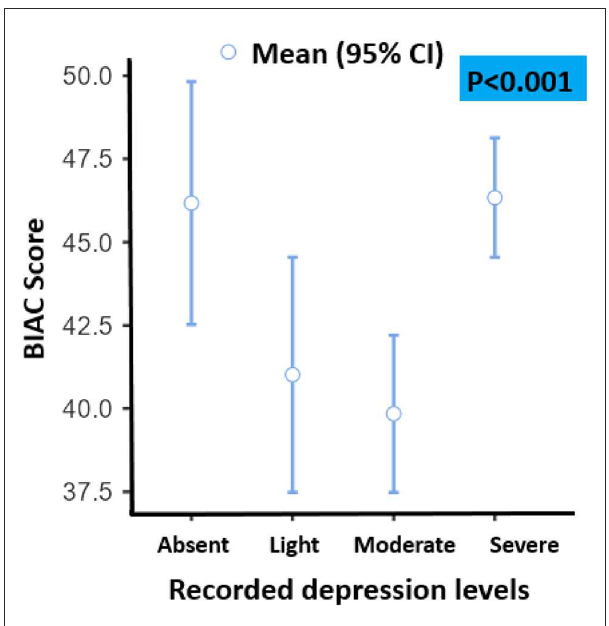
FIGURE1 BIAC scores vs. depression levels. CI, confidence